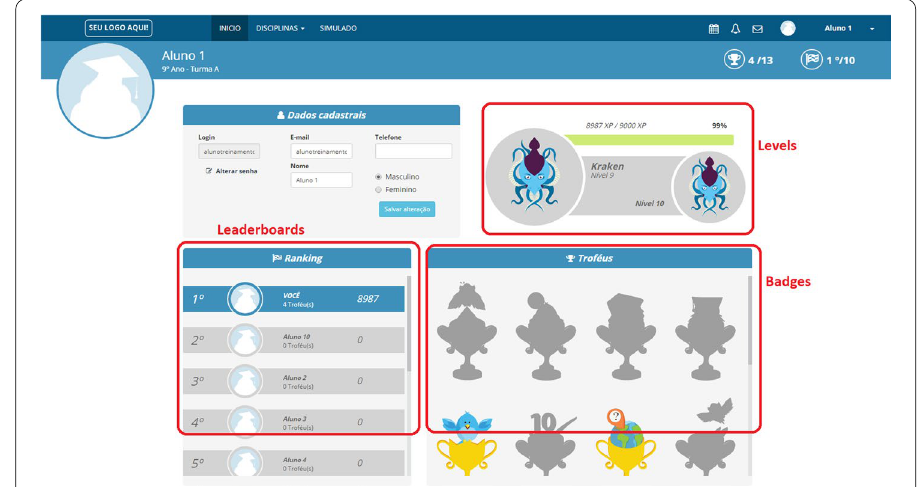
Fig. 4 MeuTutor default version (Student profile)